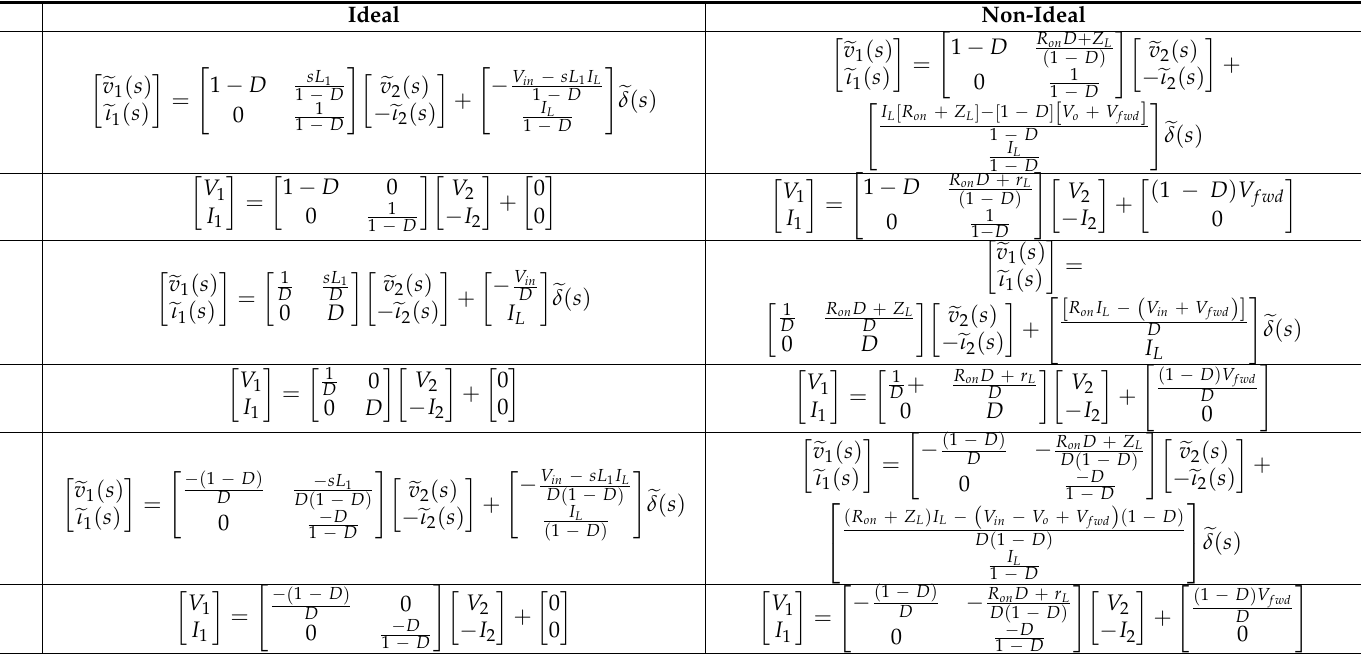
Table 2. Small-signal and steady-state models for Type 1